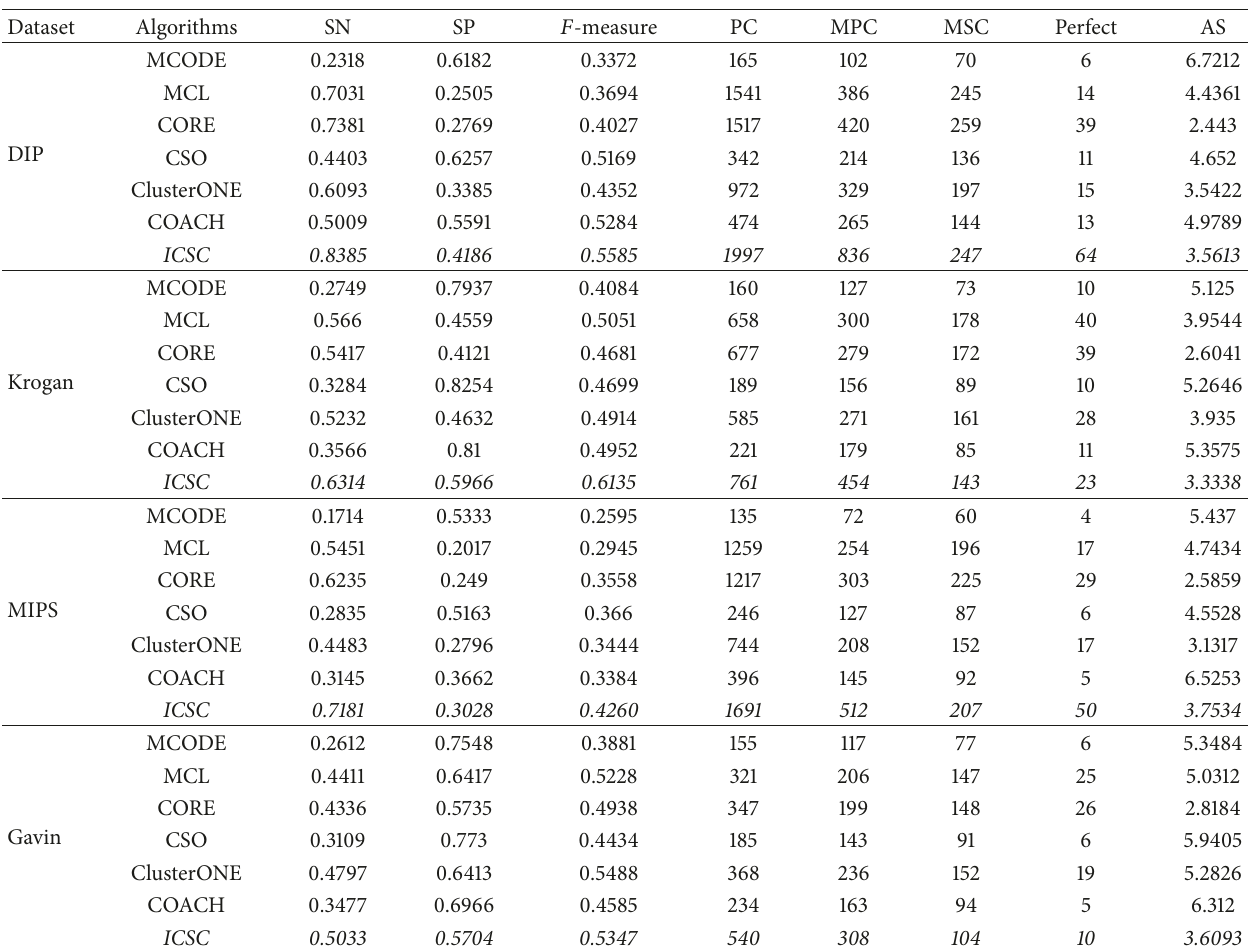
Table 2: The performance comparison of several typical algorithms on four datasets. Dataset